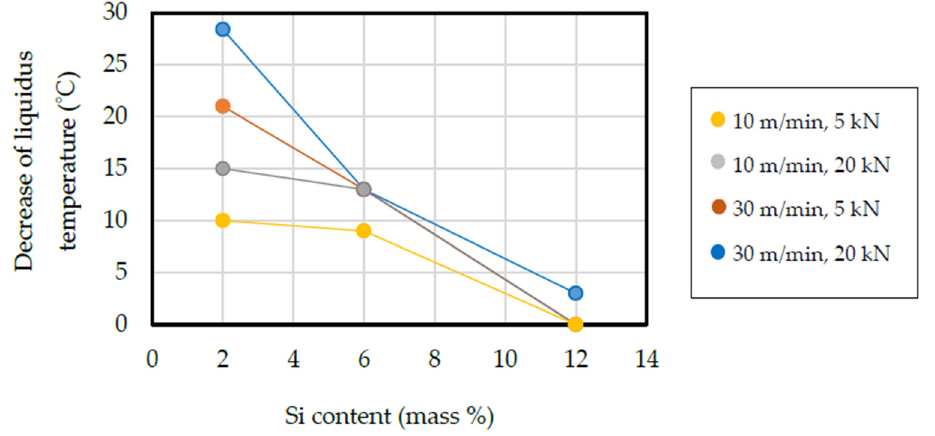
Figure 6. Effects of roll speed, roll load, and Si content on decrease in the liquidus temperature of Al-Si alloy from equilibrium. Roll speed: 10 m/min and 30 m/min; roll load: 5 kN and 20 kN; Si content: 2%, 6%, and 12%.